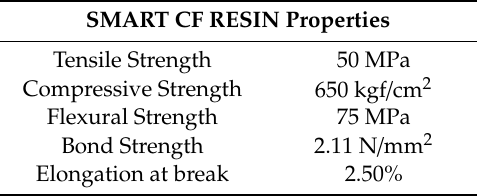
Table 3. Mechanical properties of epoxy resin.